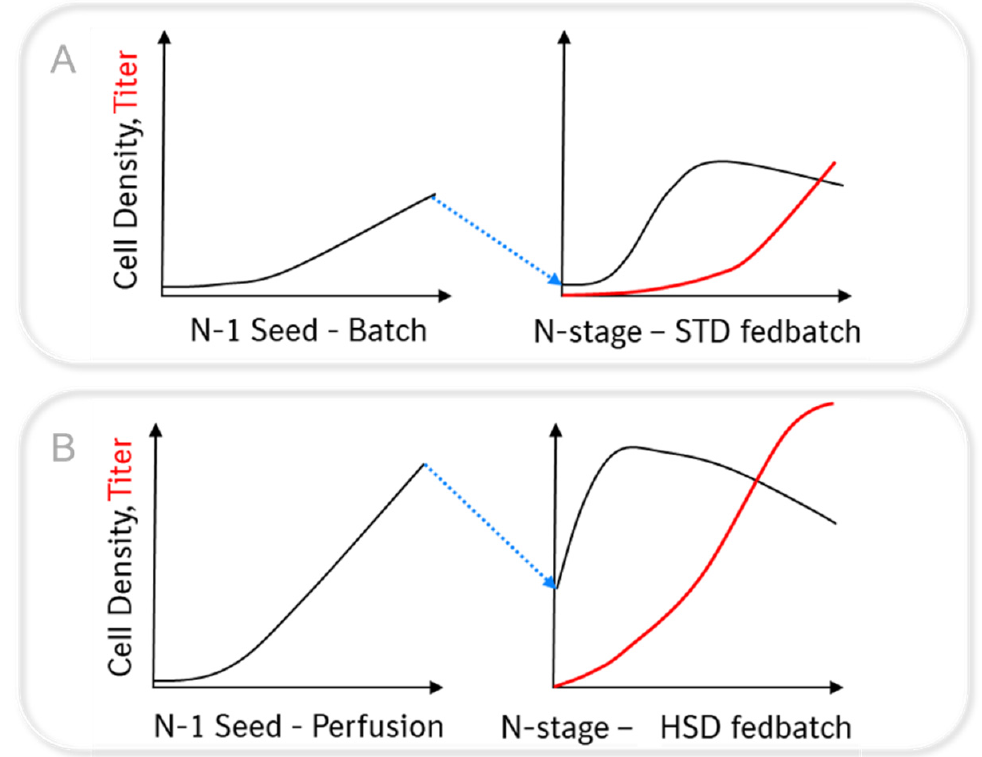
Figure 1. Illustration of N-1 prestage and N-Stage of the conventional standard (STD) process ( A ) and high seeding density process ( B ). The STD fed-batch N-Stage is inoculated with a batch N-1 stage, while the HSD fed-batch N-Stage is inoculated with an N-1 perfusion stage, where cells are retained through a filter module to reach high cell densities. Black color line describes cell density and red line describes titer. Blue dotted arrow describes transfer from N-1 into N-Stage.